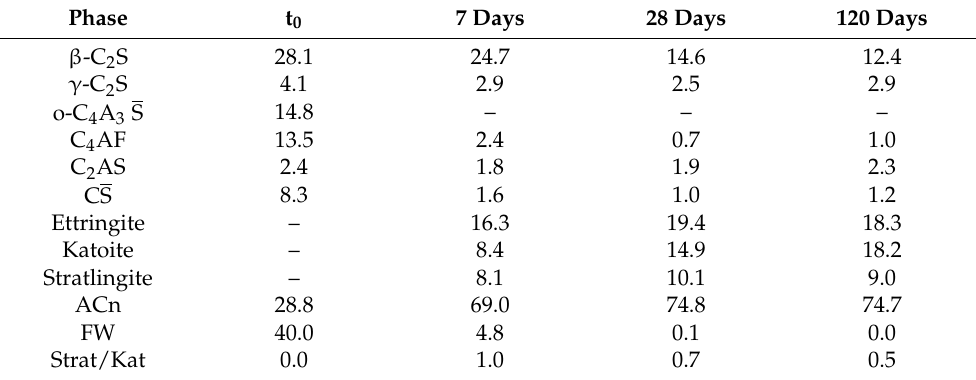
Table 3. RQPA, including ACn and FW of st-BYF with w/c = 0.40, 0.1 wt % of SP and 0.25 wt % of B 2 O 3 added as borax (st-BYF-wc040_01SP_0.25B 2 O 3 ), per 100 g of anhydrous cement. Stratlin- gite/katoite ratio is also included.